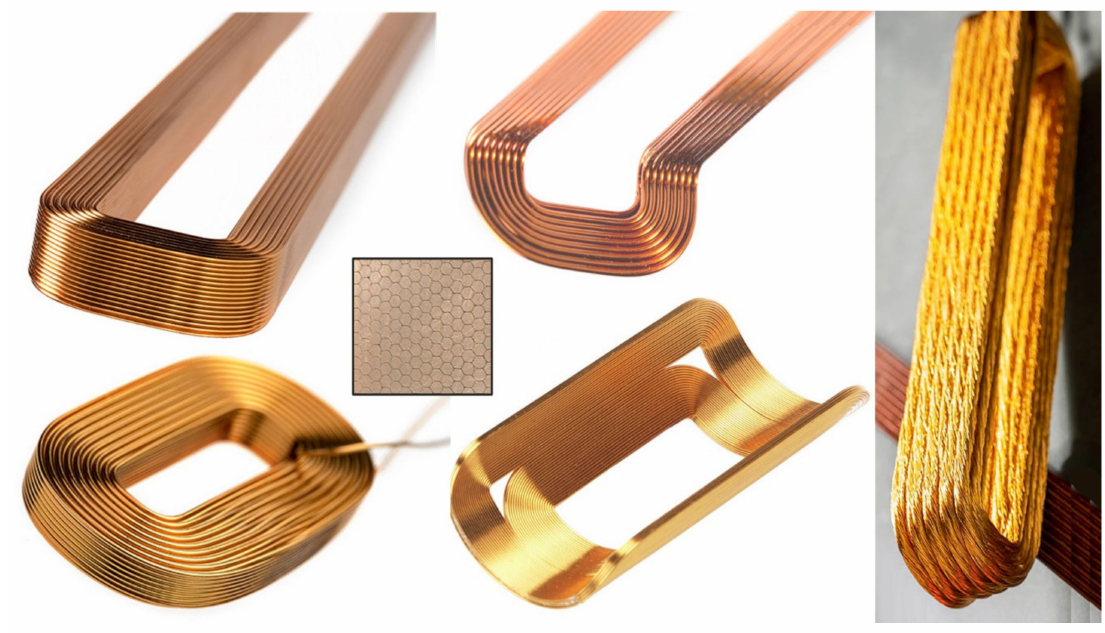
Figure 11. Orthocyclic coils with different custom shapes